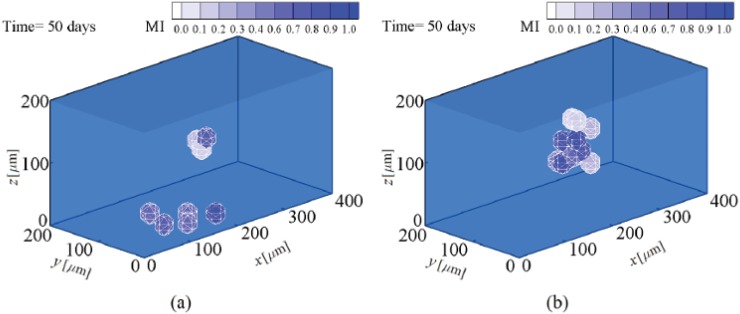
Chondrocyte proliferation in intermediate substrates.a- 20 kPa and b- 25 kPa stiffness (see also S3 Video).